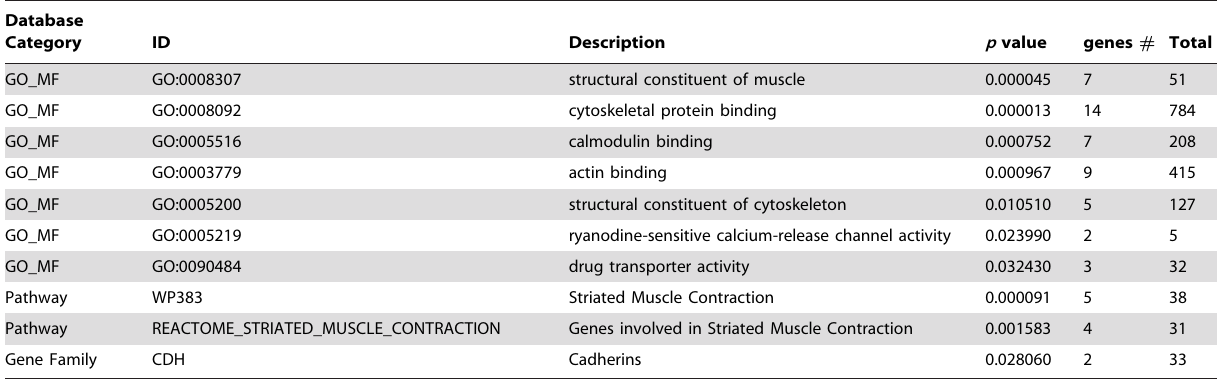
Table 4. Lung GO enrichments analyses.